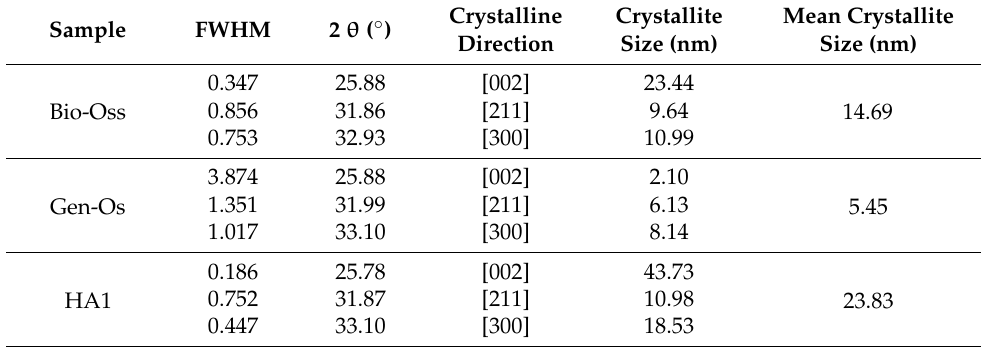
Table 2. Crystallite size by Scherer equation for the highest crystalline